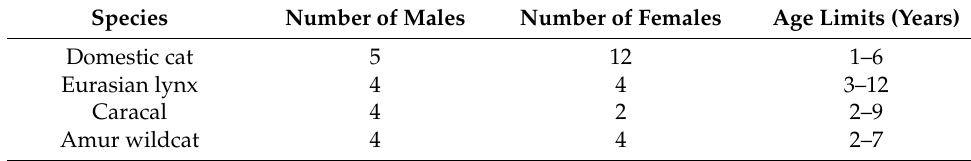
Table 1. Number of experimental